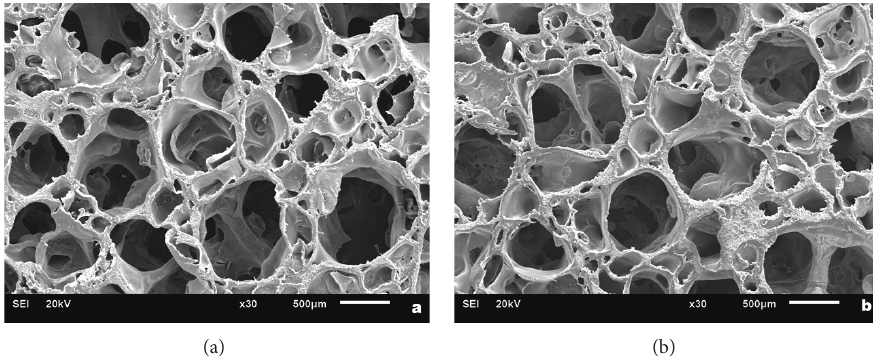
Figure 1: SEM photographs of the nHA/PA66 scaffolds with 40wt% nHA (a) and 50wt% nHA (b).